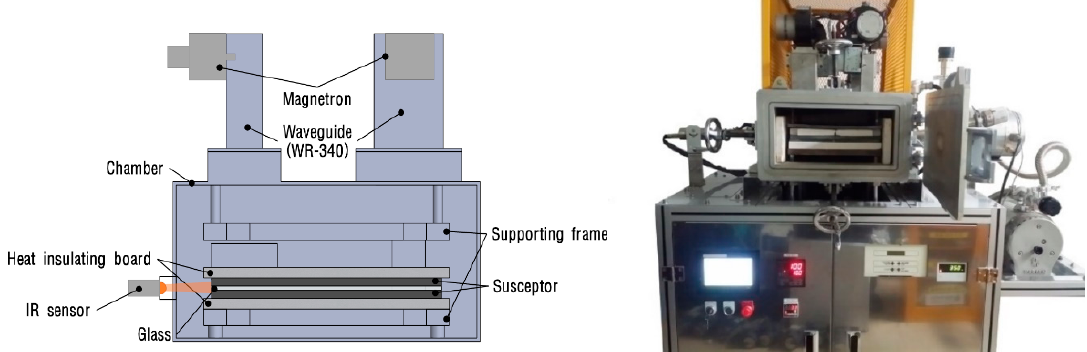
Figure 6. Schematic illustration ( left ) and image of the experimental microwave glass-heating chamber ( right ).